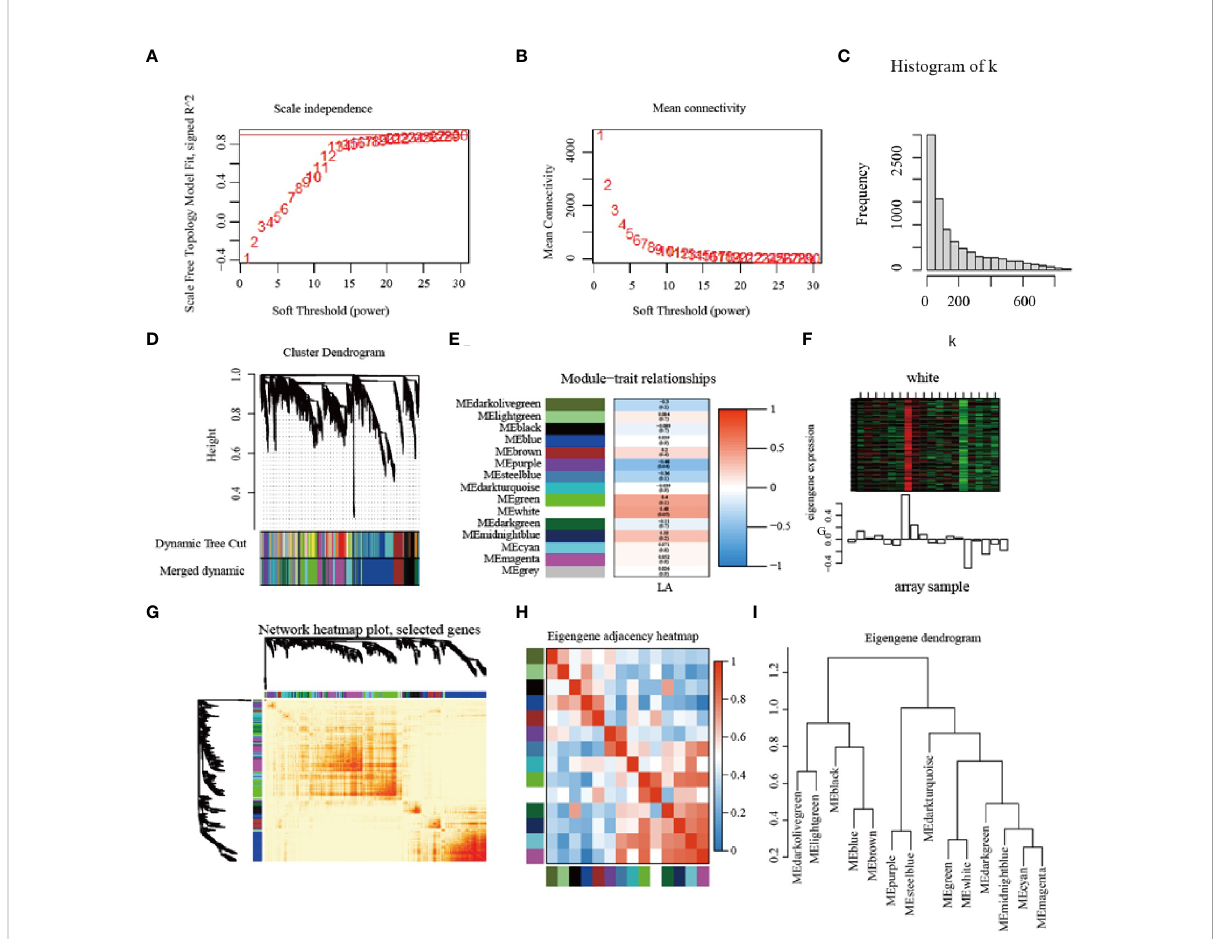
FIGURE 8 Construction of modules based on weighted gene co-expression network analysis. (A – C) Soft power value screening of differentially expression genes for LA related co-expression modules; (D) Establishment of the cluster dendrogram in LA co-expression mod-ules. (E) The correlation between modules and LA; (F) White module; (G) Network heatmap; (H, I) Module clustering. LA = leaf